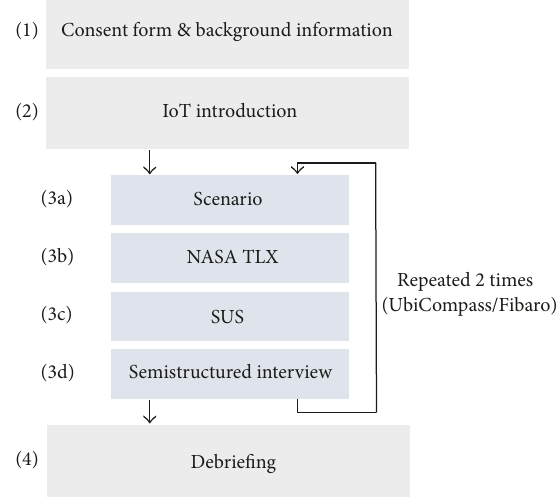
Figure 6: Test session